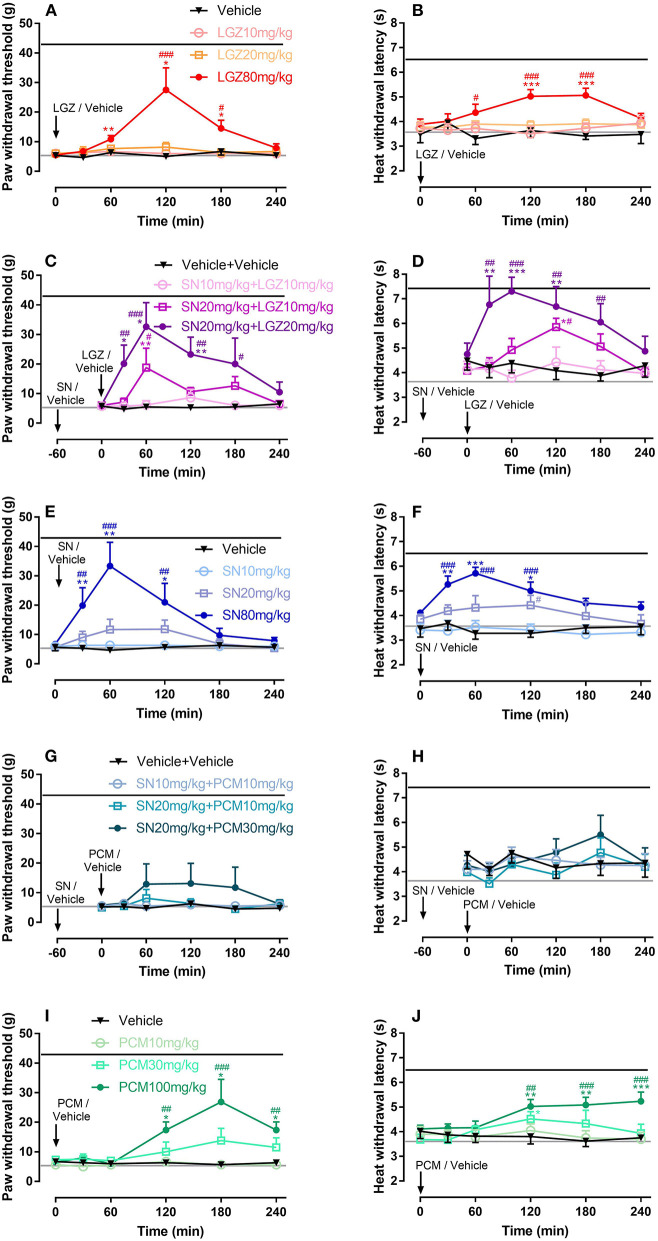
Dose dependent effects of LGZ (A,B), SN (E,F), PCM (I,J); and SN combined with LGZ (C,D) or PCM (G,H) on mechanical and heat hypersensitivities in rats with incisional pain. N = 6–8 rats, data were presented as mean ± SEM. Black or Gray lines represent the average (mechanical / heat) thresholds, before or 1 day after incision, respectively. LGZ was applied at the dosages of 10, 20, and 80 mg/kg (A,B); SN was applied at the dosages of 10, 20, and 80 mg/kg (E,F); PCM was applied at the dosages 10, 30, and 100 mg/kg (I,J); SN (at 10 or 20 mg/kg) were applied 60 min before LGZ (at 10 or 20 mg/kg; C,D), or PCM (at 10 or 30 mg/kg; G,H) administrations. Mechanical/heat thresholds were measured for 240 min after completion of drug applications. Two Way ANOVA with repeated measures indicated overall significant differences (P < 0.05) between the groups (A–J). *P < 0.05, **P < 0.01, ***P < 0.001, post-drug thresholds were compared with pre-drug baselines at 0 min, using Dunn's (A,C,E,G,I) or Dunnett's (B,D,F,H,J) multiple comparisons test following ANOVA; #P < 0.05, ##P < 0.01, ###P < 0.001, post-drug effects were compared with vehicle treatments at each time points, using Bonferroni's multiple comparisons test following ANOVA.